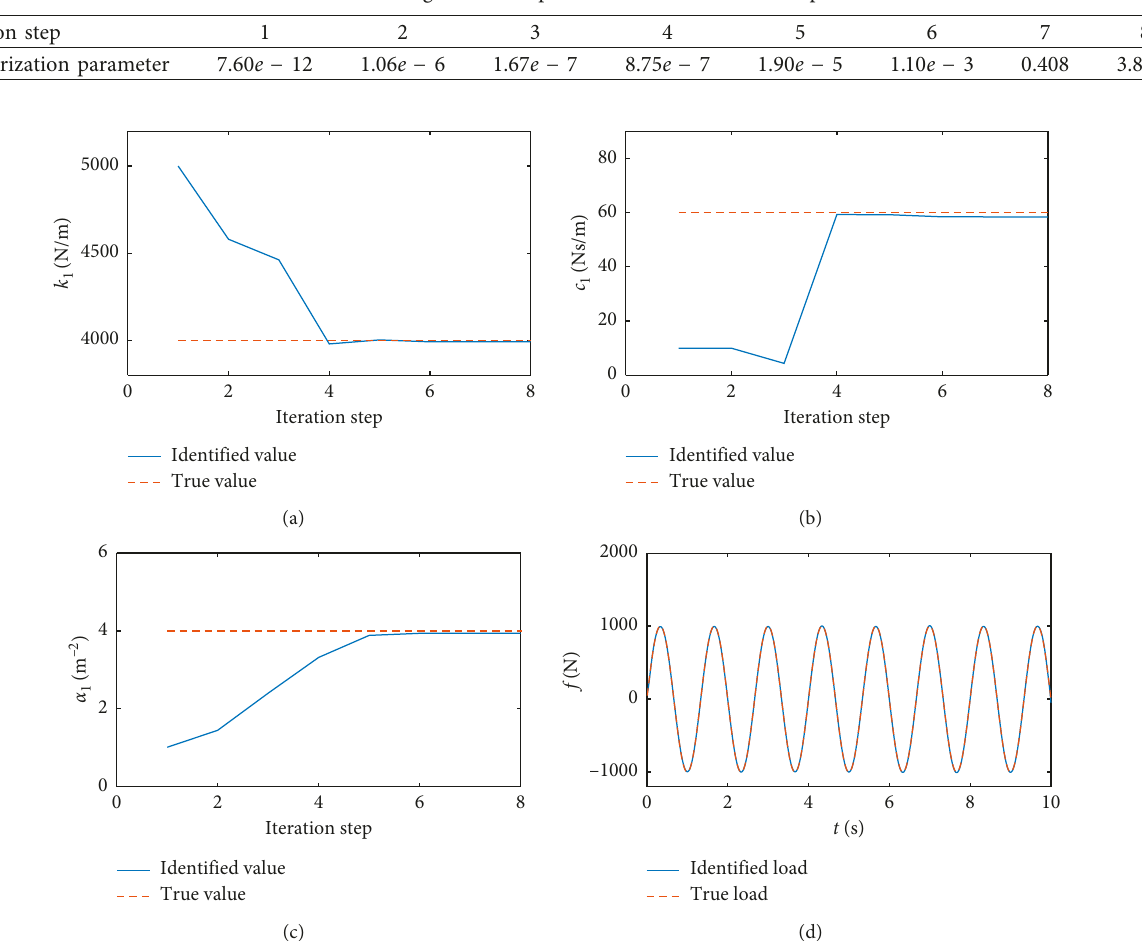
Table 1: The regularization parameters of all iteration steps.